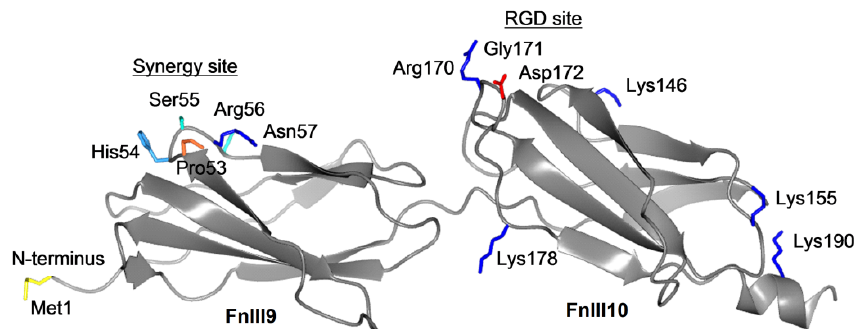
Figure 8. Ribbon diagram of the human fibronectin 1 type-III repeat 9-10 fragment. The structure was modeled based on the fibronectin fragment PDB id 1FNF [29] and visualized with the CCP4mg 2.10.11 software [30].